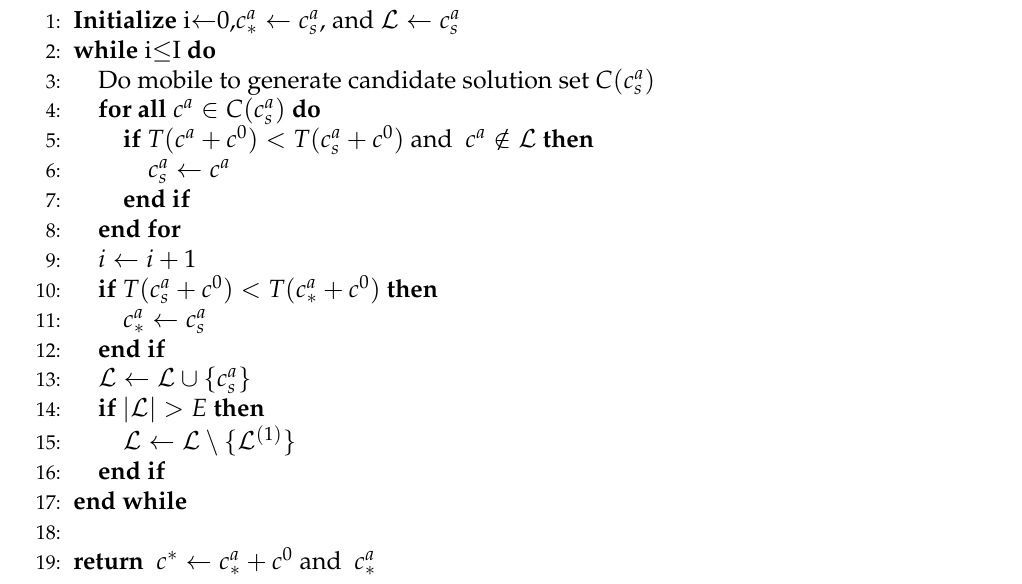
Algorithm 1 Fixed Budget Charging Resources Planning Algorithm